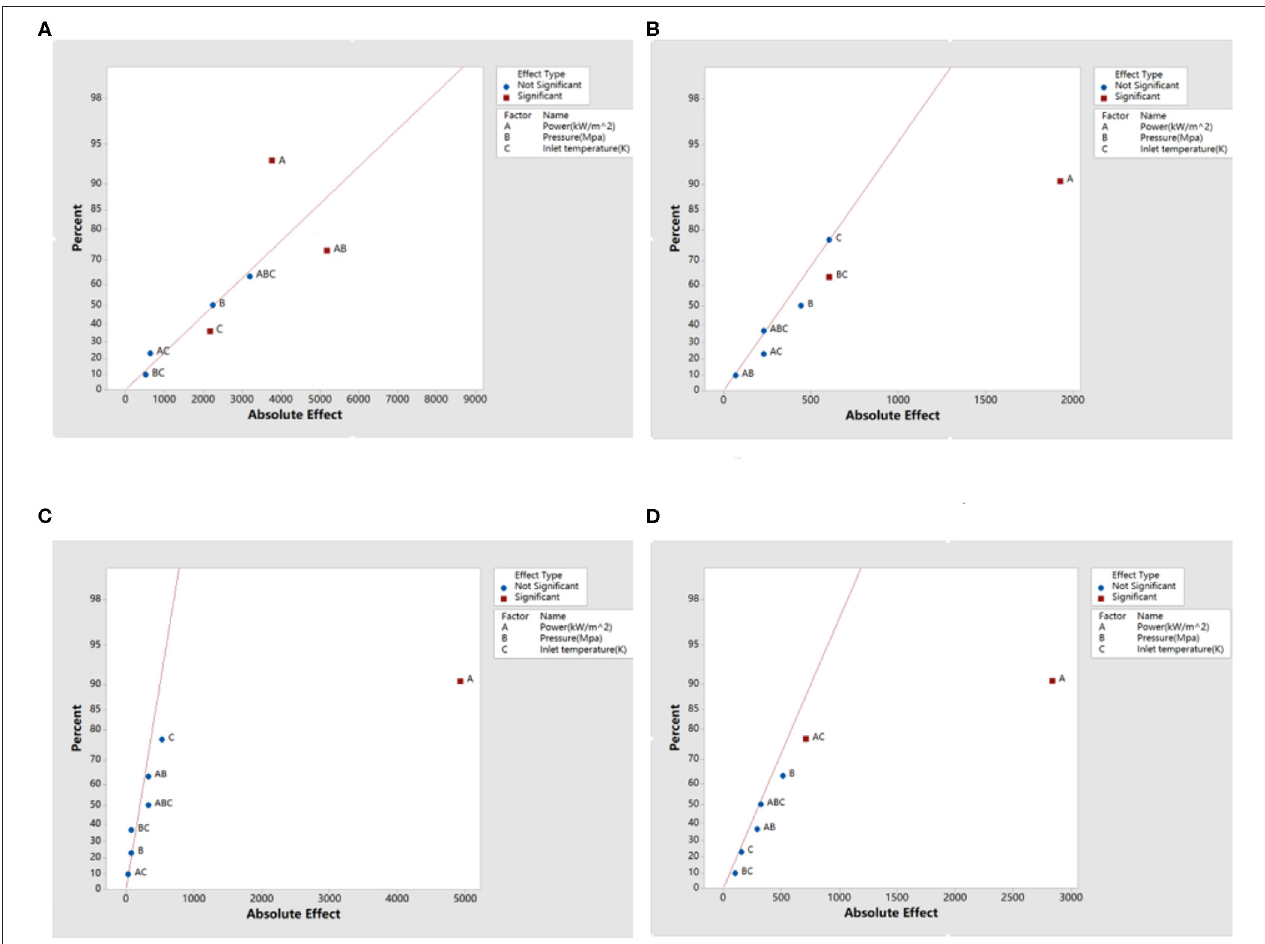
FIGURE 12 | Semi-normal probability of the effect of heat transfer coefficient. (A) Effect of heat transfer coefficient of sodium, (B) effect of heat transfer coefficient of sodium-potassium alloy, (C) effect of heat transfer coefficient of lead, and (D) effect of heat transfer coefficient of lead-bismuth.